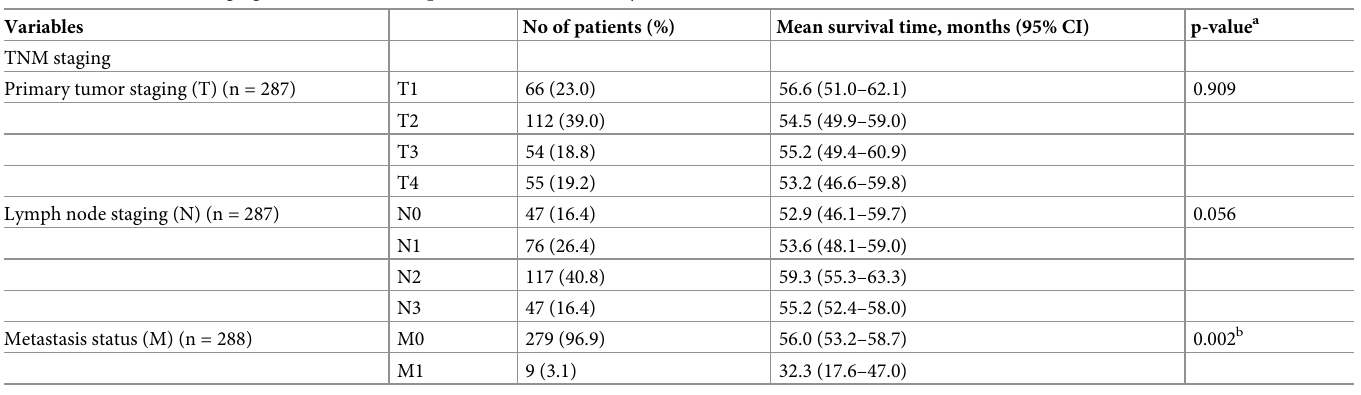
Table 3. Effect of TNM staging on survival of NPC patients (univariate analysis, N = 300).